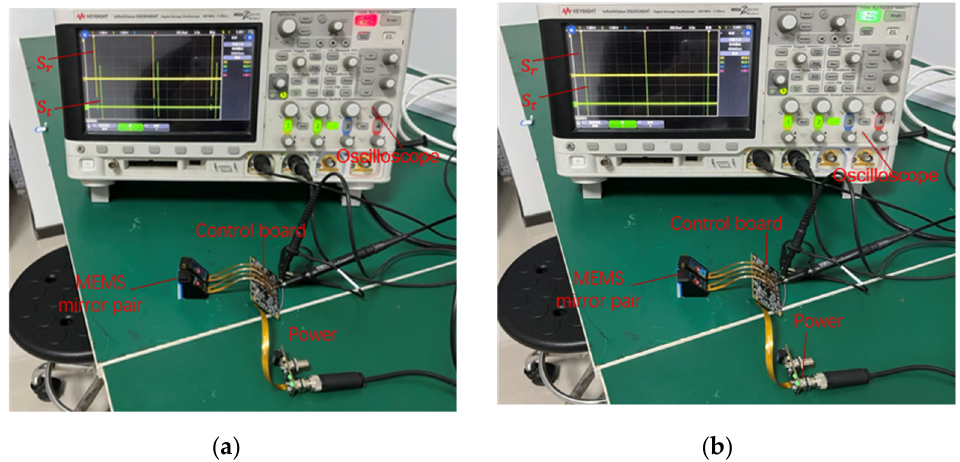
Figure 7. ( a ) Picture of the experiment before MEMS mirror synchronized; ( b ) picture of the experiment after MEMS mirror synchronized.